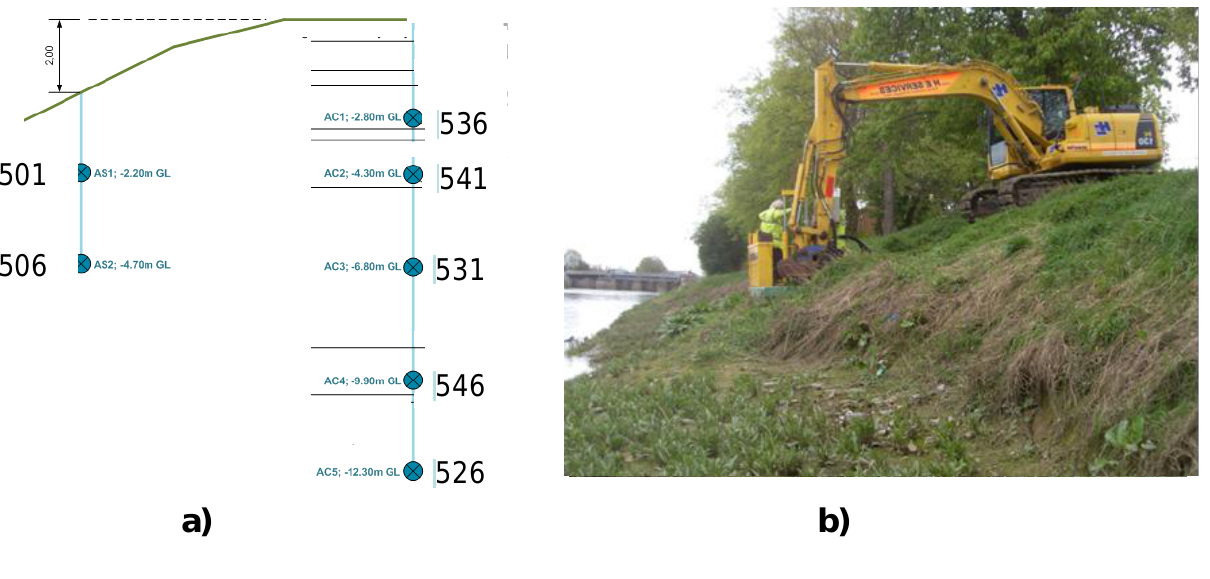
Figure 20. ( a ) One of two cross-section of the Boston levee, circles with numbers show installed pore pressure sensors. ( b ) A photo of the Boston